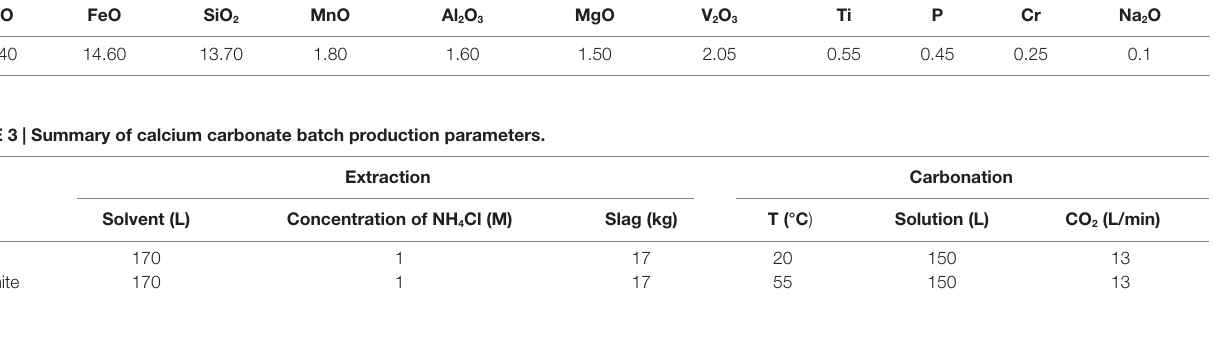
TaBle 2 | summary of the XrF analysis of steel converter slag (only compounds found in amounts ≥ 0.1 wt-% listed). caO FeO